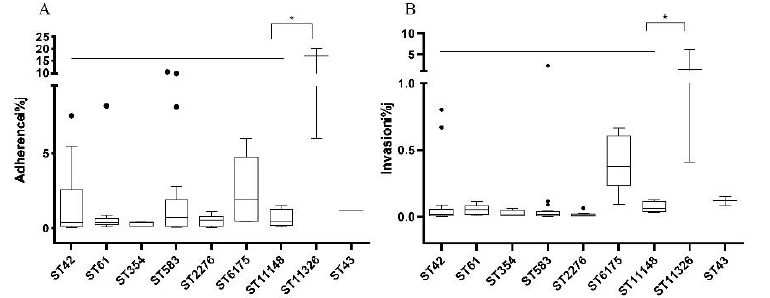
Figure 3. The adherence ( A ) and invasion ( B ) rates of isolates of different STs. The point ( • ) out of boxes indicates moderated outliers, the line in boxes represents mean value of the STs, the asterisk (*) represents a statistically significant difference ( p < 0.05) between STs and the adherence or invasion rate.